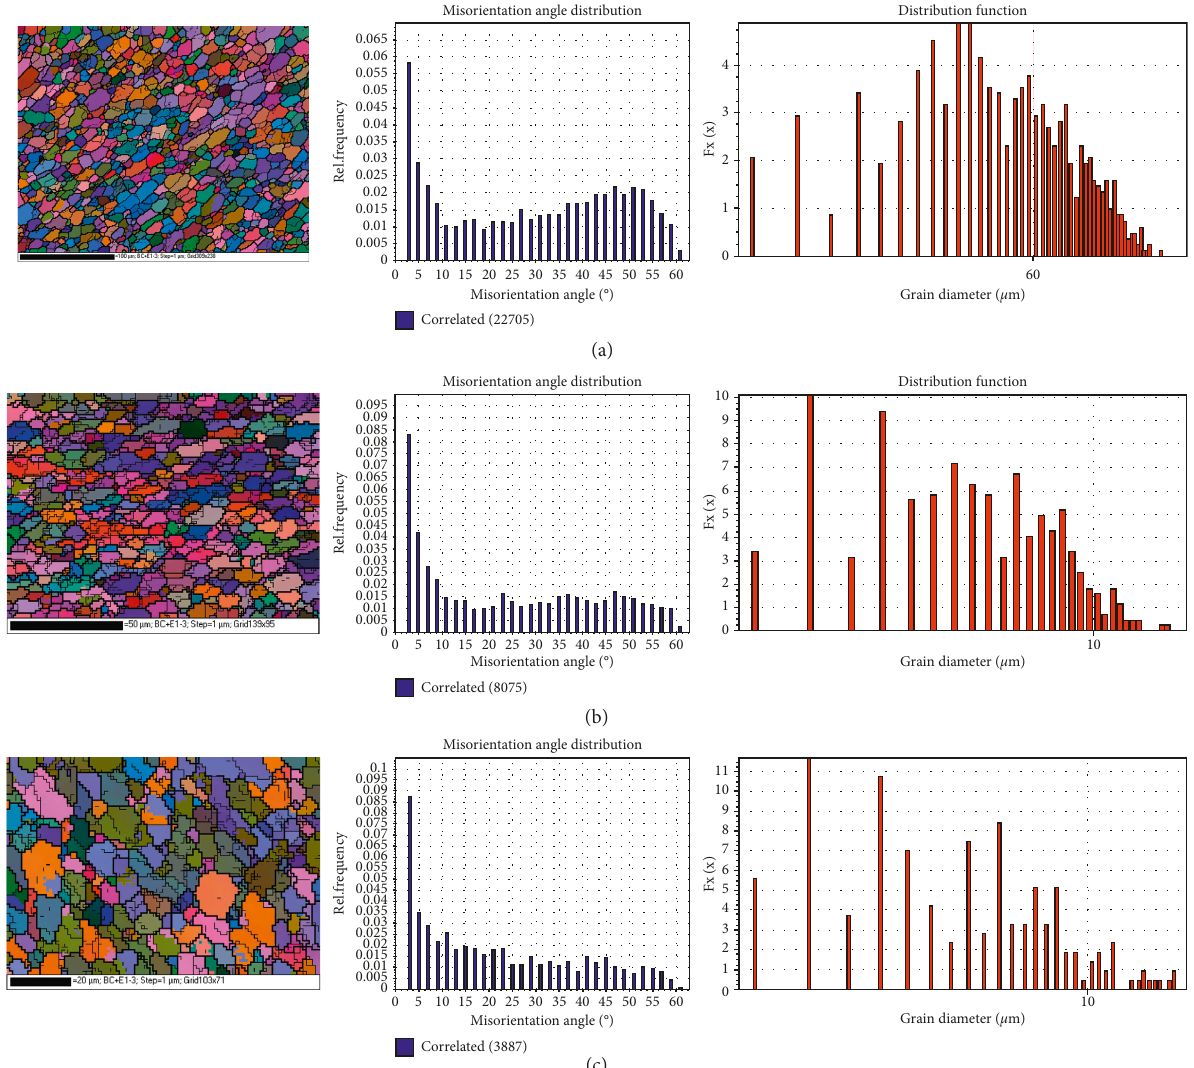
Figure 11: Orientation imaging grain boundary maps (left column), their corresponding histogram for the misorientation angle dis- tribution (middle column), and subgrain size distributions (right column) for friction stir welded joints welded at 1070rpm and different feed rates: (a) 36mm/min; (b) 70mm/min; (c) 140mm/min. Average misorientation angle: (a) 26 ° ; LAGB: 31%; HAGB: 69%; (b) 24 ° ; LAGB: 44%; HAGB: 56%; (c) 21 ° ; LAGB: 48%; HAGB: